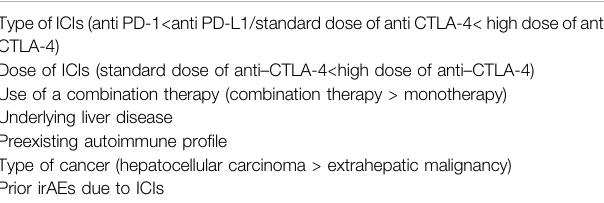
TABLE 2 | Incidence of ICI-mediated hepatotoxicity reported in the main clinical trials evaluating ICIs. Adapted from Peeraphatdit et al. (2020). Medication Incidence of Incidence of grade 3 – 4 hepatotoxicity (%)